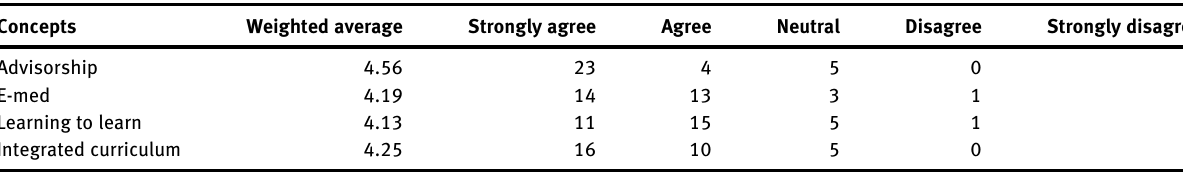
Table  : Results of a  –  Likert-scale online survey about the student satisfaction of key concepts of “ Next Generation Medical Education ” in IUE Faculty of Medicine.